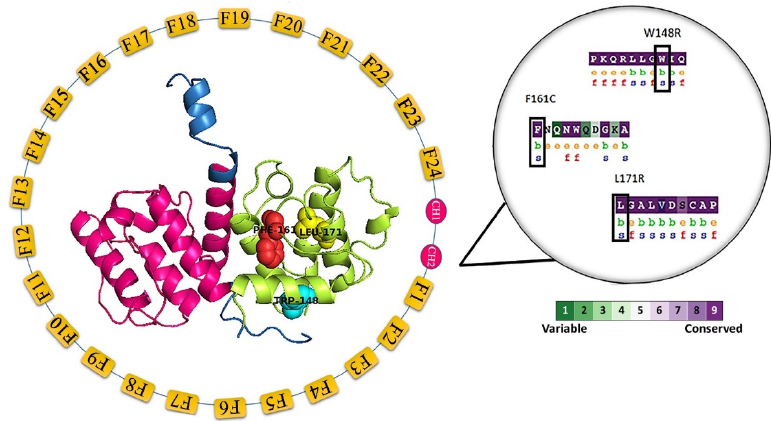
Figure 1. A schematic representation of a domain and the interpretation of the three variants’ evolutionary and conservation analysis (W148R, F161C, and L171R). The native protein structure (PDB ID: 2WA5) describes the variant sites in the center. The calponin-homology 1 (CH1; residues from 16–122) and calponin-homology 2 (CH2; residues from 139–242) are represented in magenta oval color; whereas repeated Filamin domains (F1–F24; residues from 249–2601) are represented in the yellow box. The variants W148R, F161C, and L171R are represented in cyan, red, and yellow spheres. The magnified image depicts all three variants that are structurally important and buried.